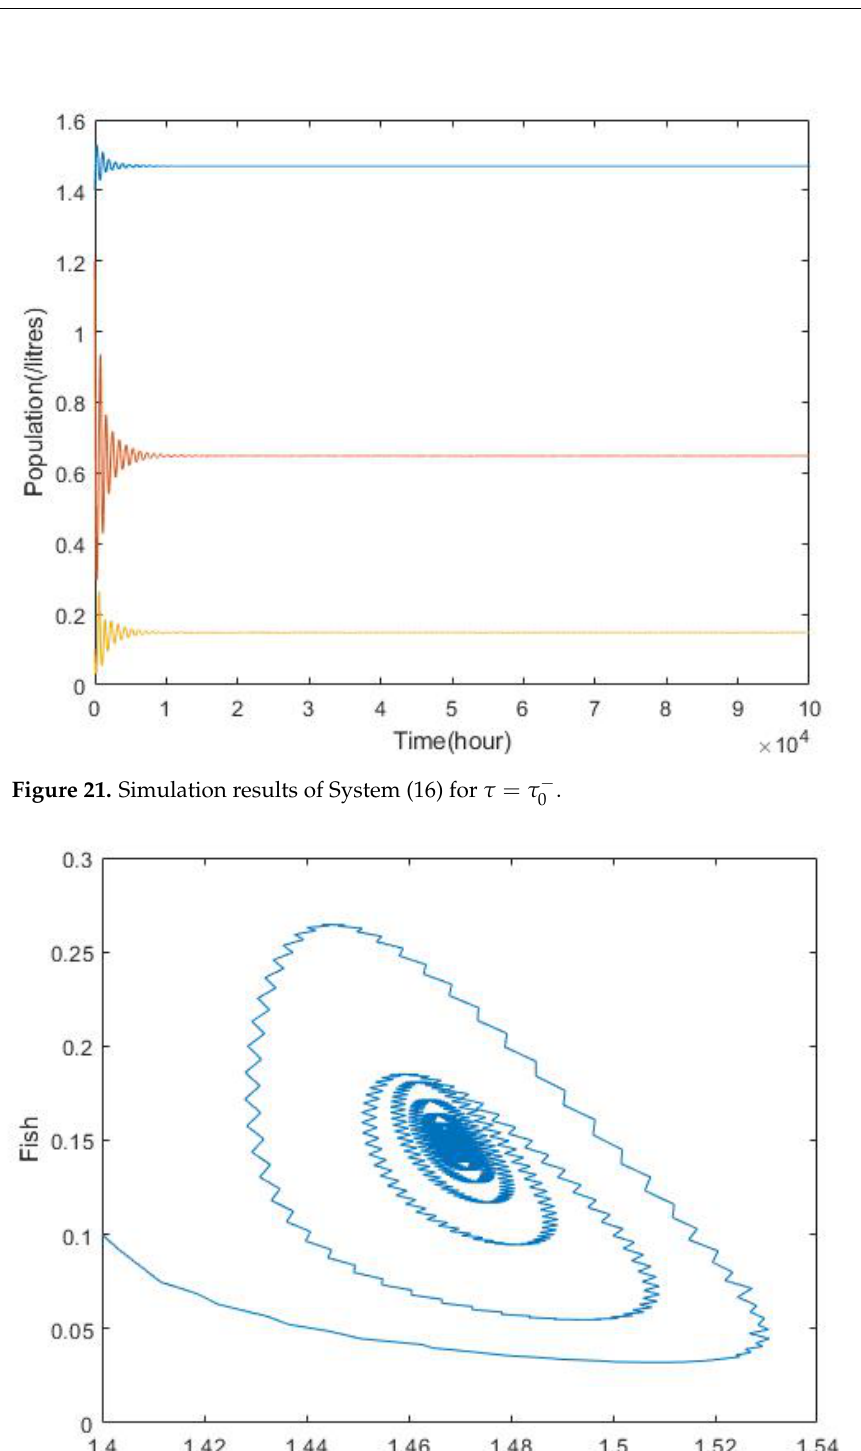
Figure 22. The asymptotical stability between the TPP and fish populations for τ = τ −